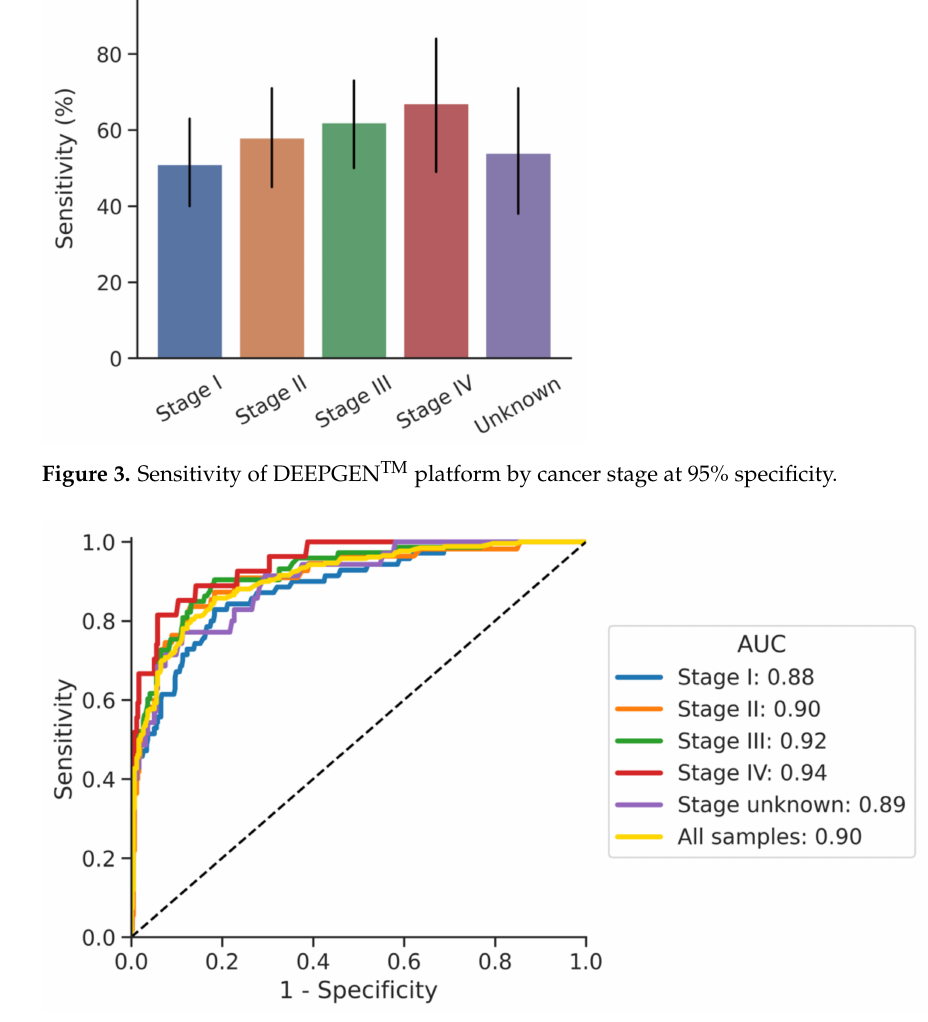
Figure 4. ROC curves for cancer